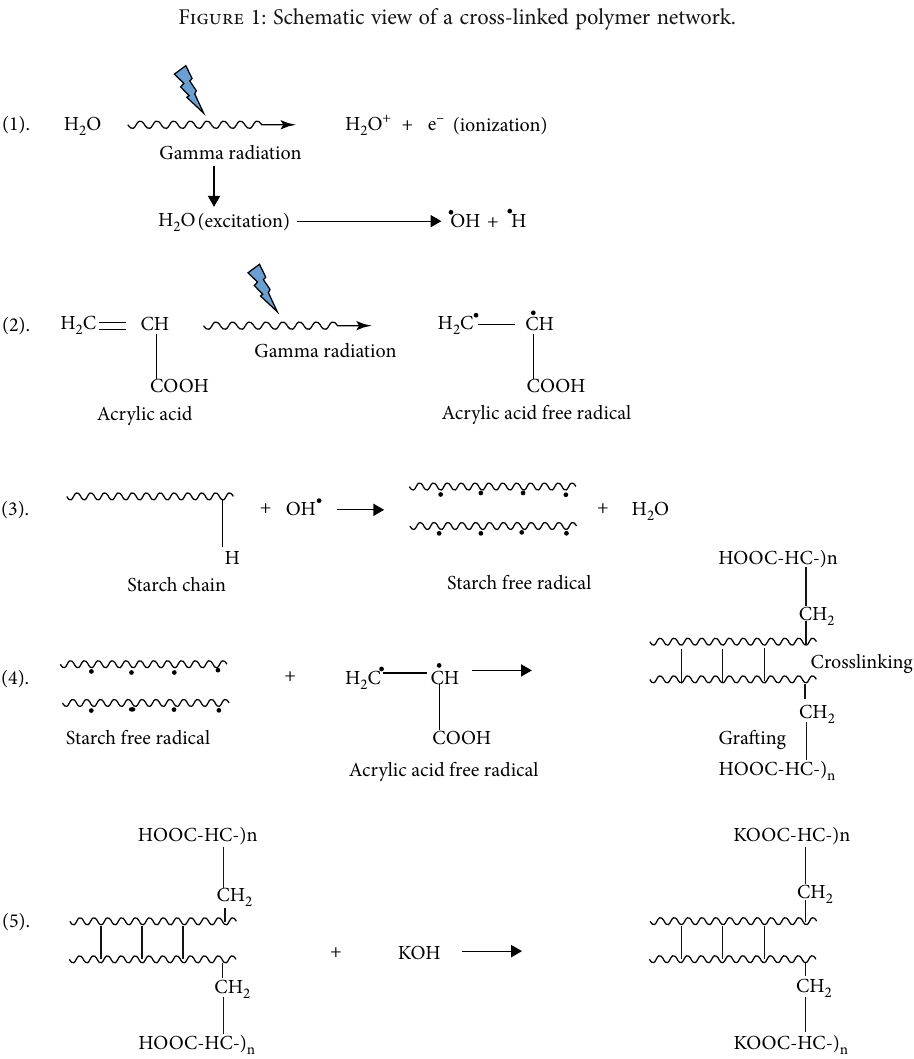
Figure 2: Possible grafting and cross-linking reaction mechanism of